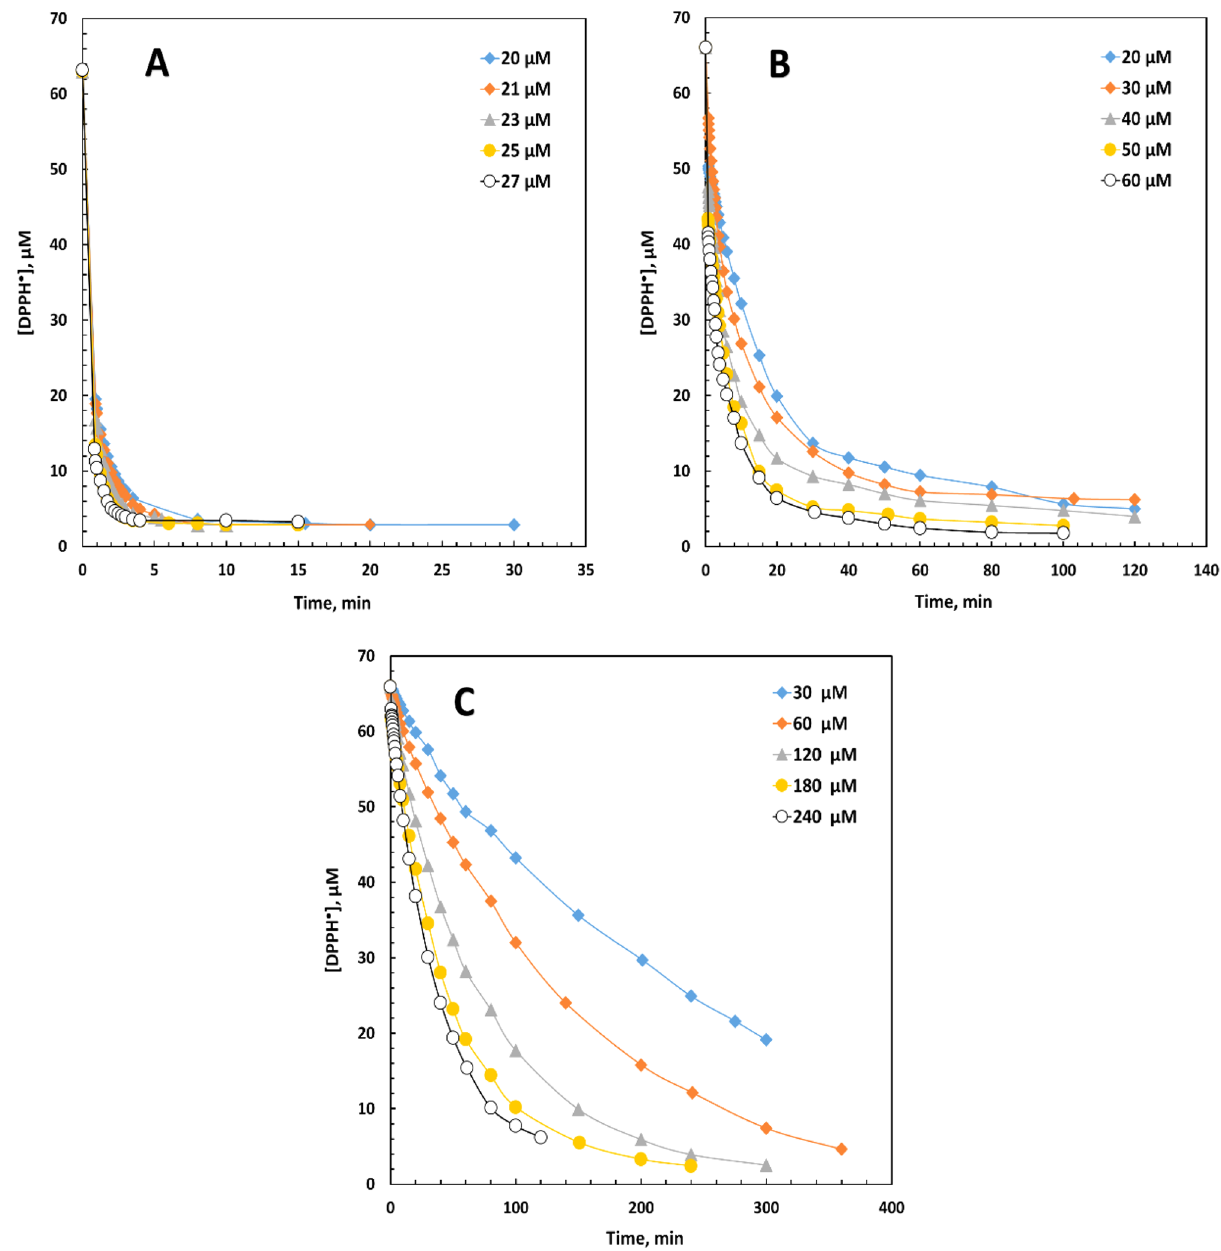
Figure 2. The kinetic curve of [DPPH · ] decay in the presence of gallic acid (GA) in ( A ) methanol, ( B ) 2-propanol, and ( C )